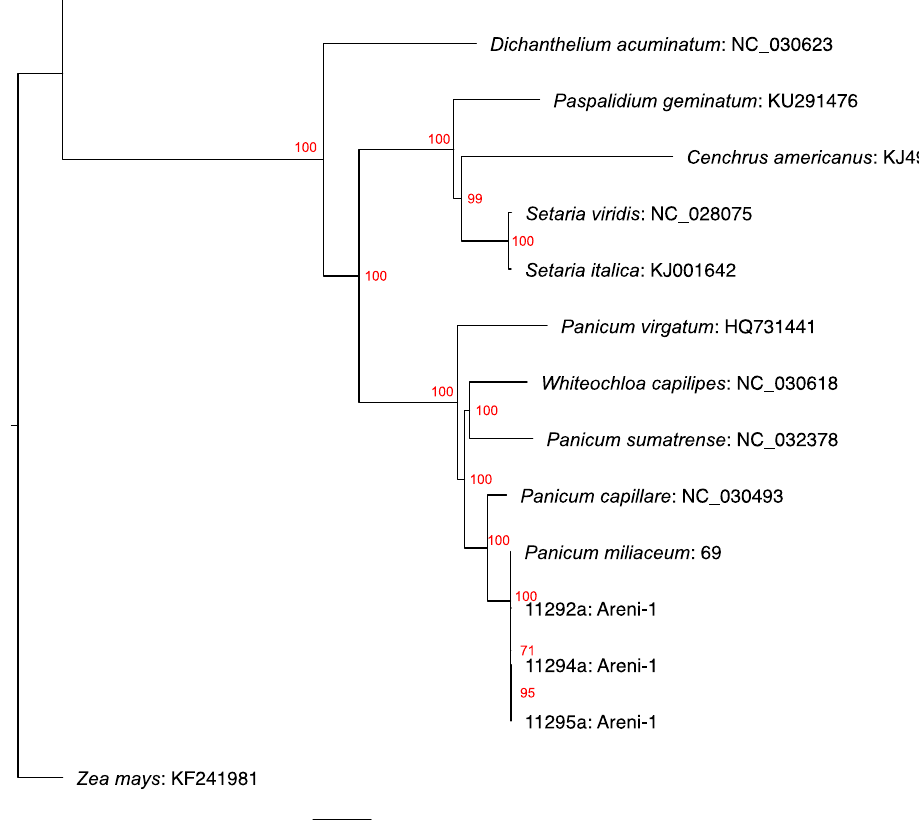
Figure 5. Paniceae chloroplast phylogeny. A phylogeny generated with chloroplast genomes (sans inverted repeat regions) from 11 modern Paniceae species and 3 Areni-1 millet grains using the RAxML program with the GTRGAMMA model 81 . The tree was rooted on the outgroup Zea mays (maize). The scale bar at the bottom of the phylogeny represents the substitutions per